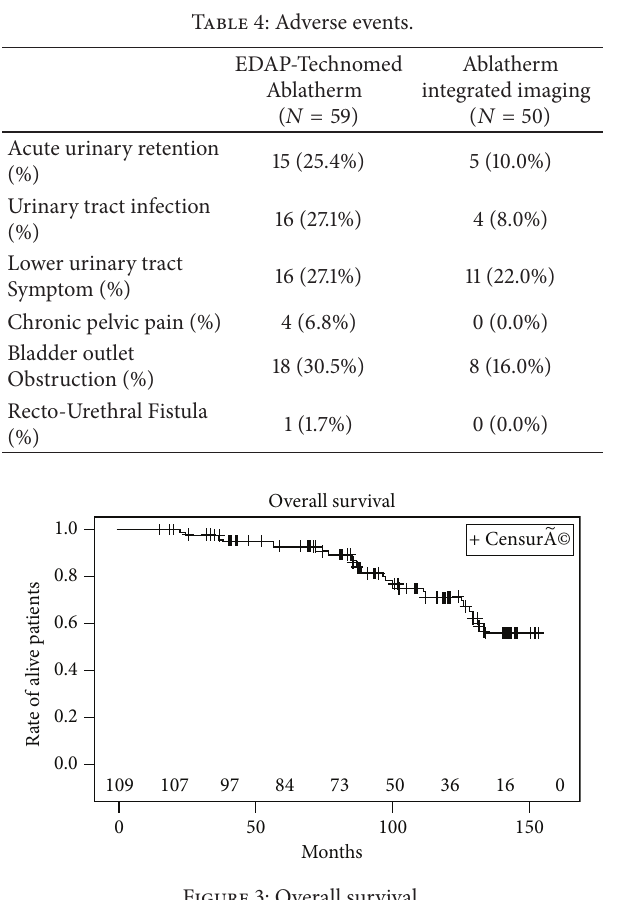
Figure 5: Distant metastasis free